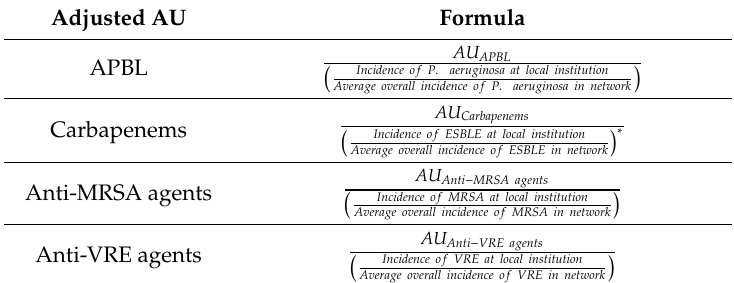
Table 2. Proposed novel metrics for adjustment of antimicrobial use by microbiological burden at each healthcare